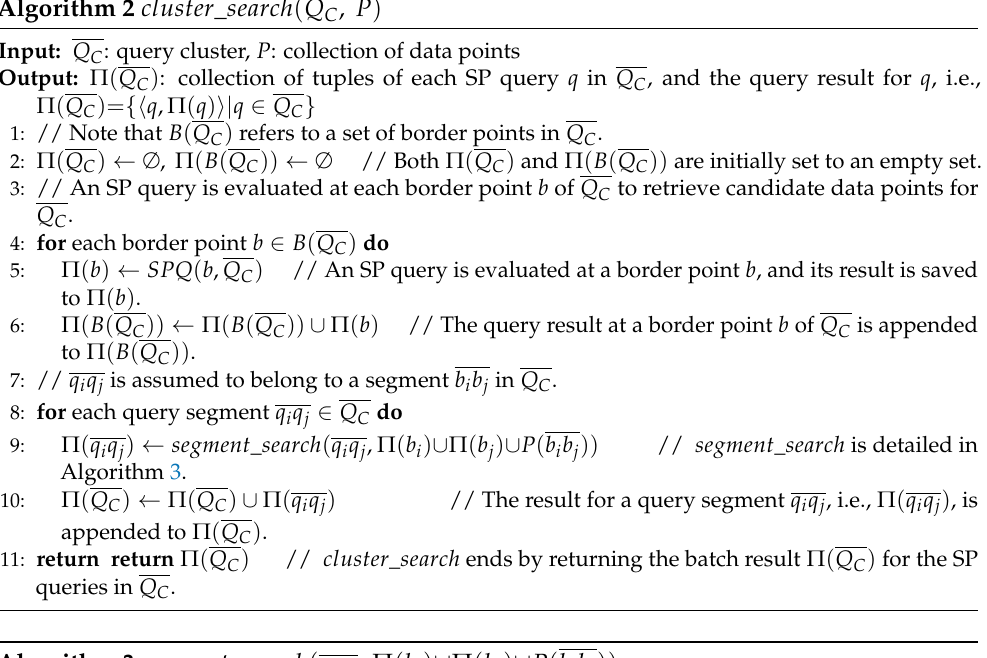
Algorithm 3 segment _ search ( q i q j , Π ( b i ) ∪ Π ( b j ) ∪ P ( b i b j ))